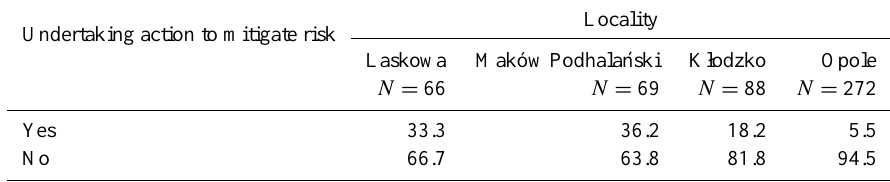
Table 8. Share of the respondents (%) from endangered areas declaring having undertaken individual investments in technical facilities to protect particular buildings against